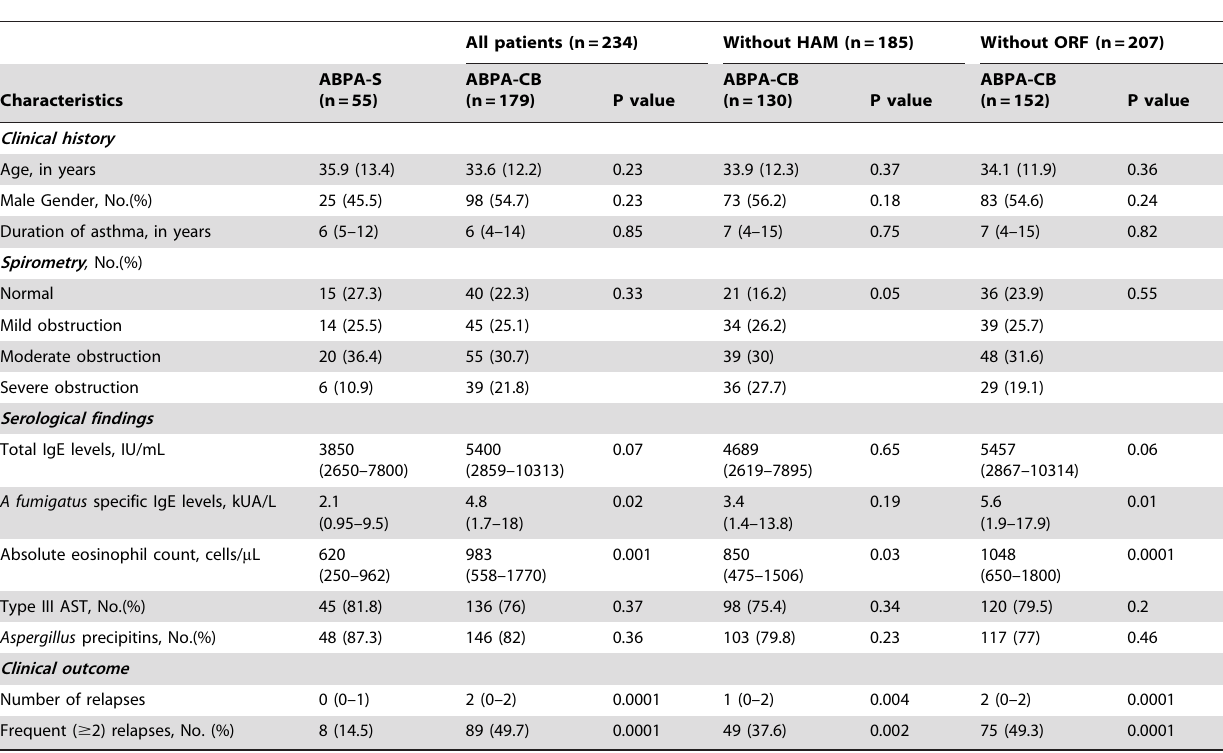
Table 2. Clinical, spirometric, serological differences and outcomes in patients with allergic bronchopulmonary aspergillosis (ABPA) based on the classification by Greenberger et al with and without the presence of high attenuation mucus (HAM) and other radiologic findings